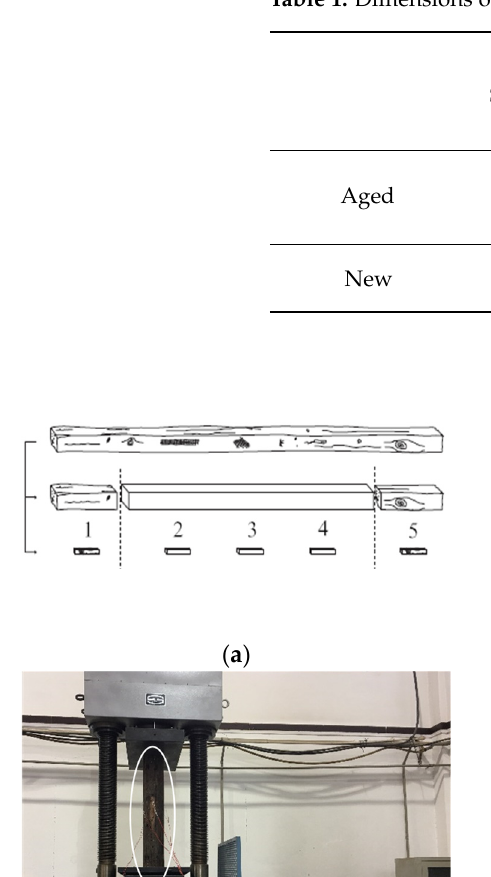
Figure 3. Log samples of aged CL and new CL: ( a ) hundred-year-old building, ( b ) aged CL samples, and ( c ) new CL samples. Table 1. Dimensions of the log samples.